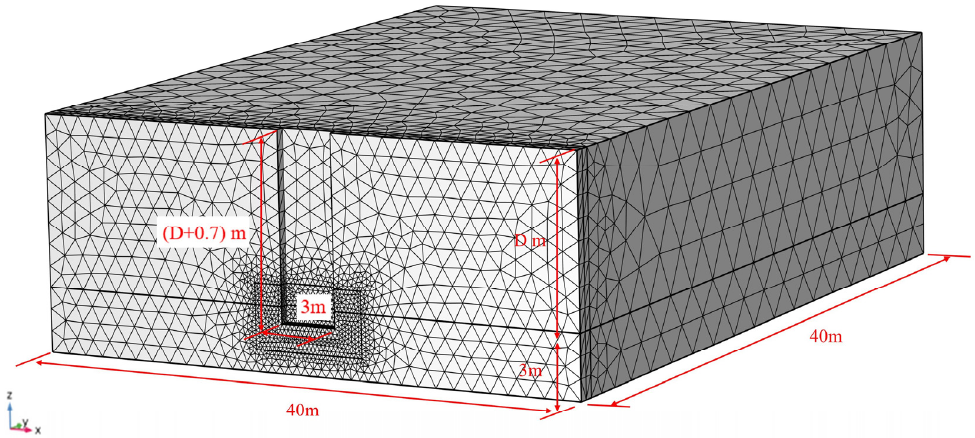
Figure 1. Numerical model of the trench excavation of a diaphragm wall in